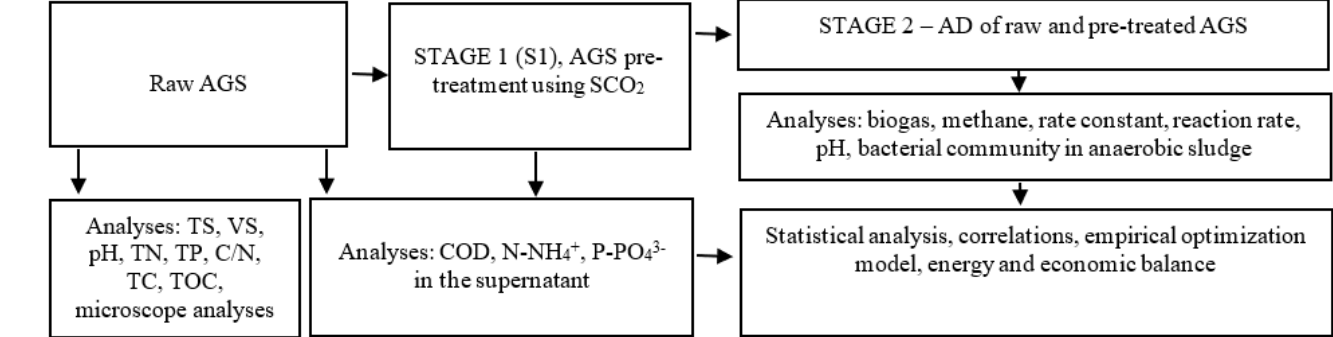
Figure 1. Block diagram of experimental, analytical, and computational works.